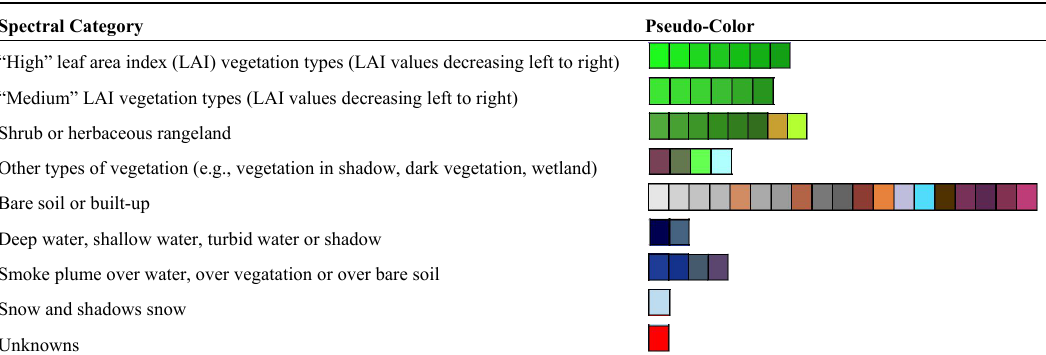
Table 4. Preliminary classification map’s legend, adopted by the QuickBird-like SIAM™ (Q-SIAM™) at fine semantic granularity, consisting of 52 spectral categories (refer to the Part 1, Table 4 [20]). Pseudo-colors of the spectral categories are grouped on the basis of their spectral end member (e.g., “ bare soil or built-up ”) or parent spectral category (e.g., “high” leaf area index (LAI) vegetation types). The pseudo-color of a spectral category is chosen so as to mimic natural colors of pixels belonging to that spectral category. This legend gives a clue about the symbolic parent-child relationships supported by Q-SIAM™ at different semantic granularity levels (refer to the Part 1, Figure 4 [20]). For example, a line-specific OR-combination of the 52 “child” spectral categories detected at the fine semantic granularity level across the nine lines of Table 4 would provide nine “parent” spectral categories at a coarser level of semantic granularity. Since it deals with symbolic reasoning, then this semantic aggregation is inherently subjective (equivocal) in nature, refer to the Part 1, Section 2.1